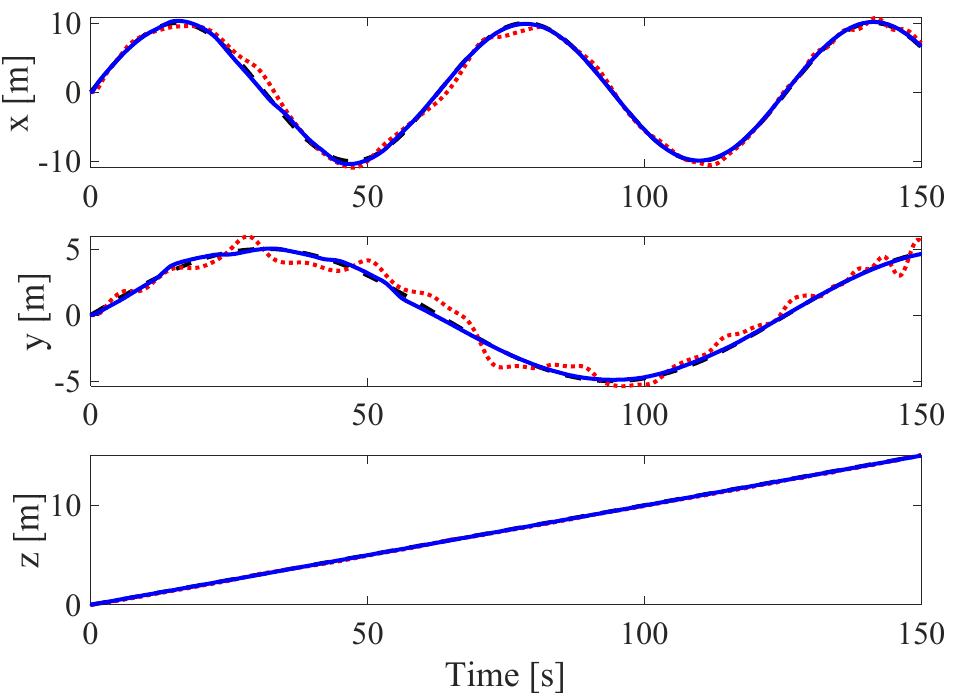
Figure 10. Position control response of two motion control systems in the presence of disturbances. The red dotted line is PID control; the solid blue line is SMC; the black dashed reference trajectory line along the z -direction is z d = 0.1 t